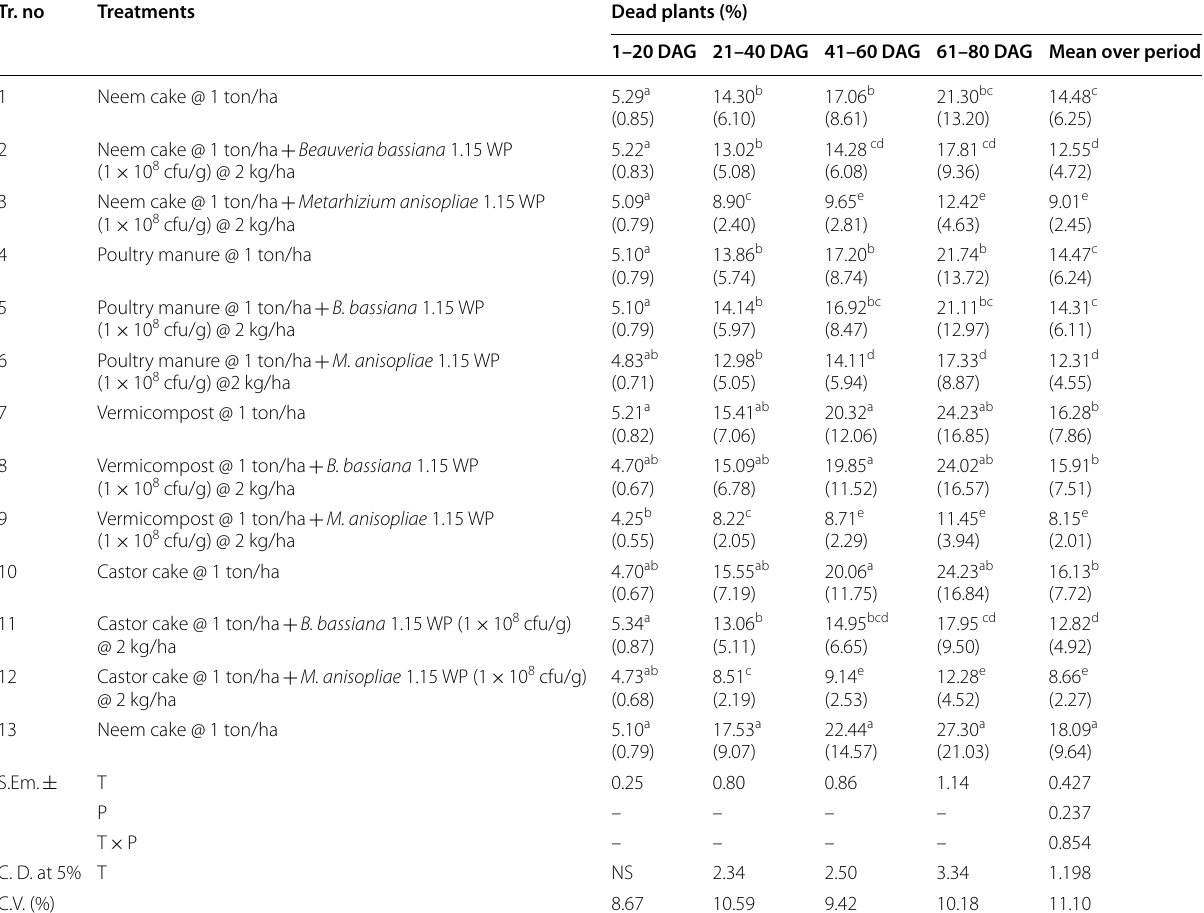
Table 4 Effect of entomopathogenic fungi enriched with organic amendments against white grub in groundnut (season of 2020) Tr.